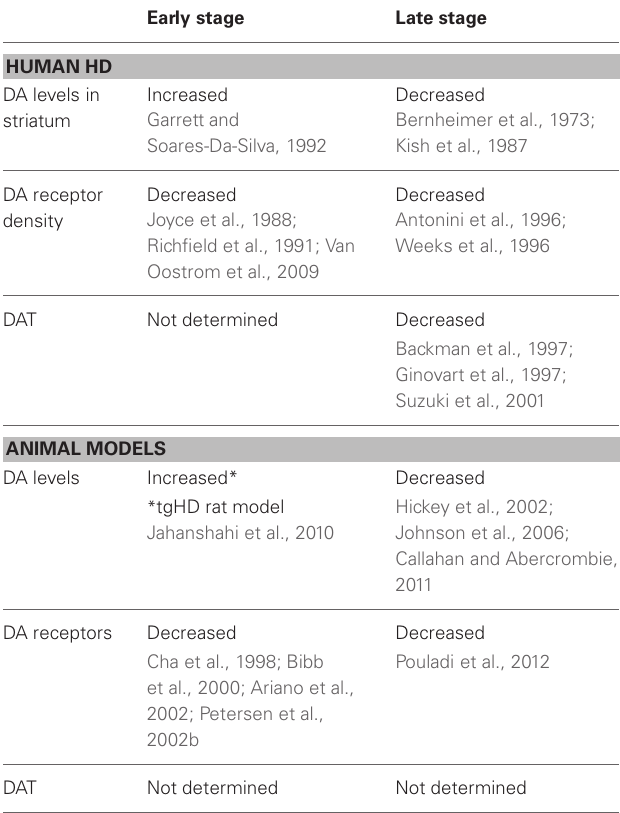
Table 1 | DA in human HD and animal